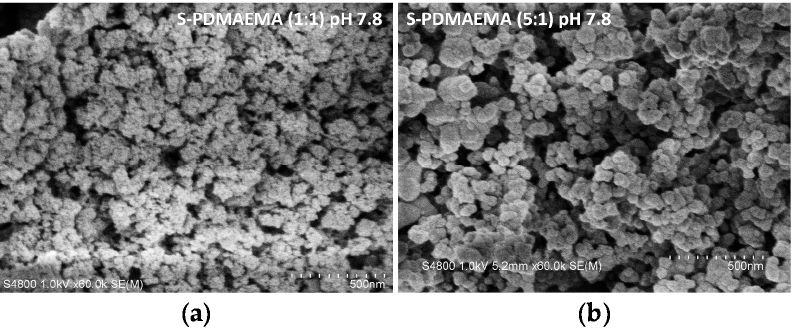
Figure 8. SEM images of water-stable and precipitated composites (60,000× magnification).